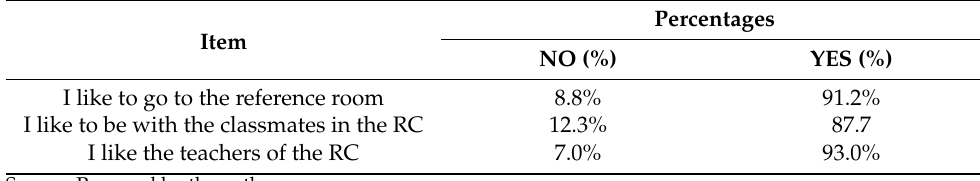
Table 6. Descriptive statistics of the attitudes of the SOC students towards their presence in the